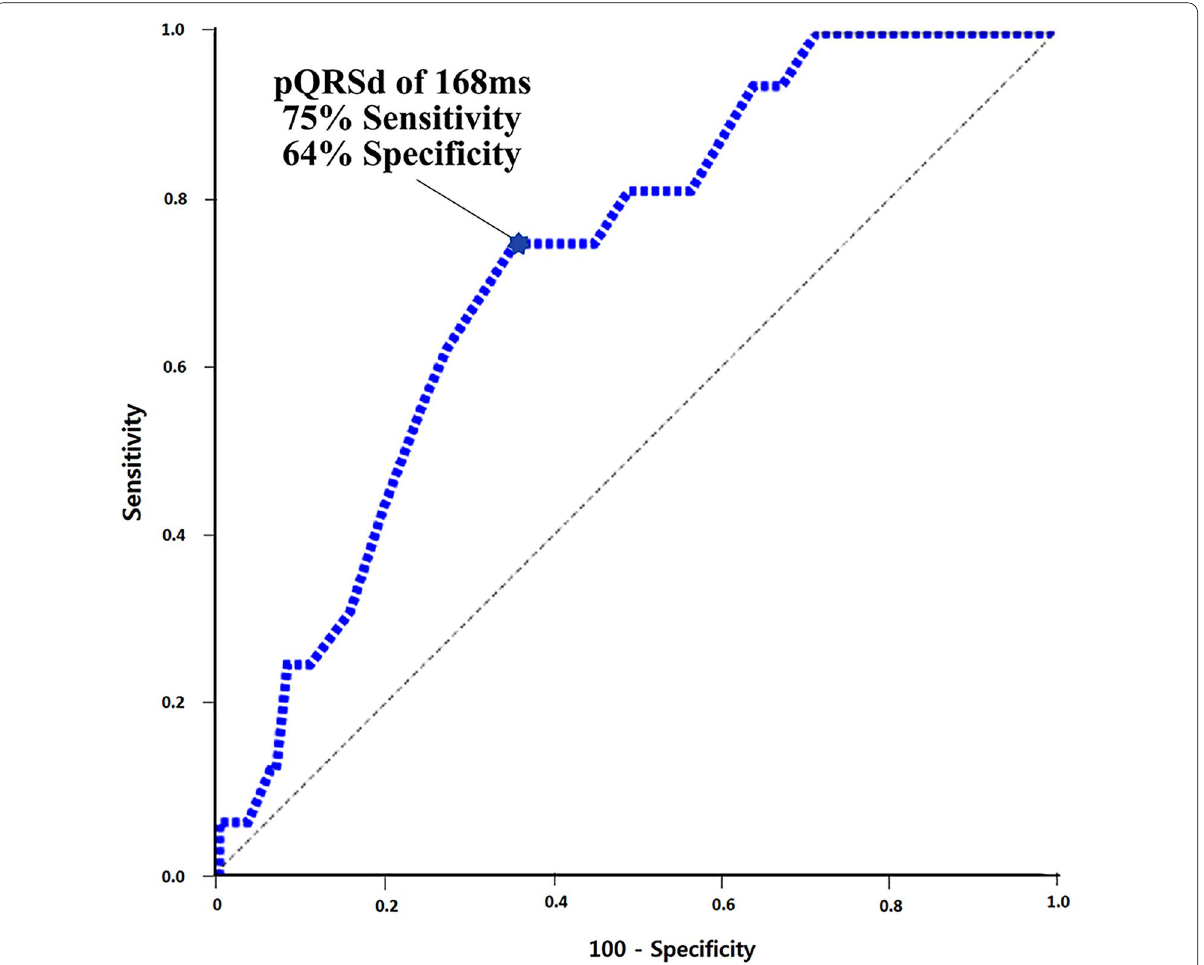
Fig. 4 Receiver operating characteristic curve (ROC) analysis. The AUC area of 0.721 (95% CI 0.610–0.833; p had a 75.0% sensitivity and a 64.2% specificity for predicting the incidence of composite clinical